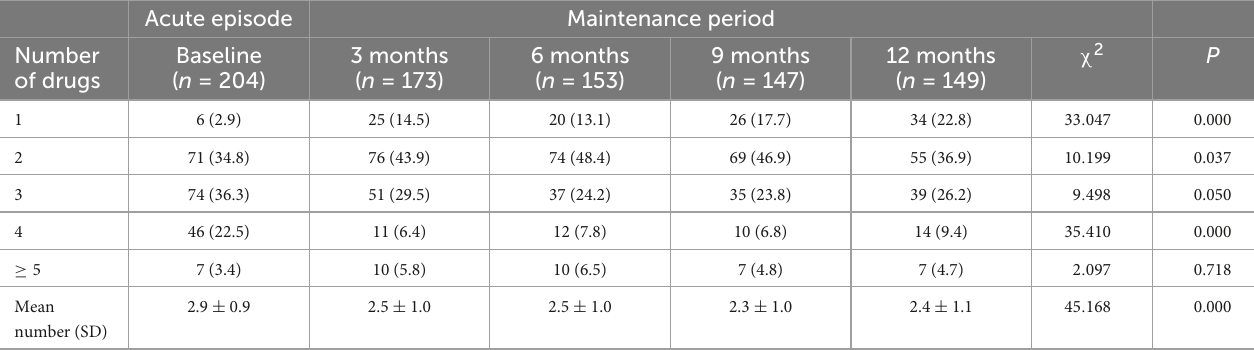
TABLE 5 Number of drugs prescribed to patients being treated for bipolar disorder, expressed as n